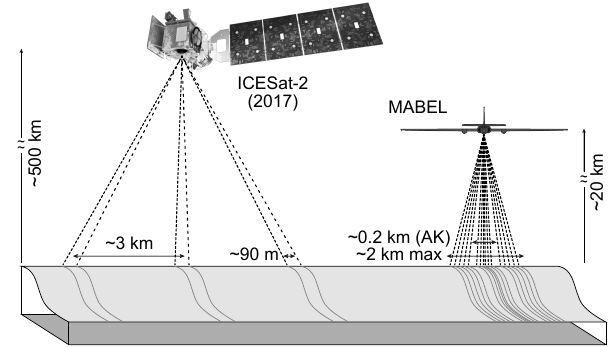
Figure 1. Schematic ICESat-2 and MABEL beam geometry (dashed lines) and reference ground tracks (grey lines along ice- sheet surface). ICESat-2 beam pairs (separated by ∼ 90m) do not have the same energy in order to keep the required laser energy low; therefore, each beam pair consists of a strong and a weak beam (as indicated by the dash difference). MABEL allows for beam- geometry changes with a maximum ground spacing of ∼ 2km at 20km. However, for the 2014 AK deployment, the maximum ground spacing was 0.2km (after Brunt et al.,